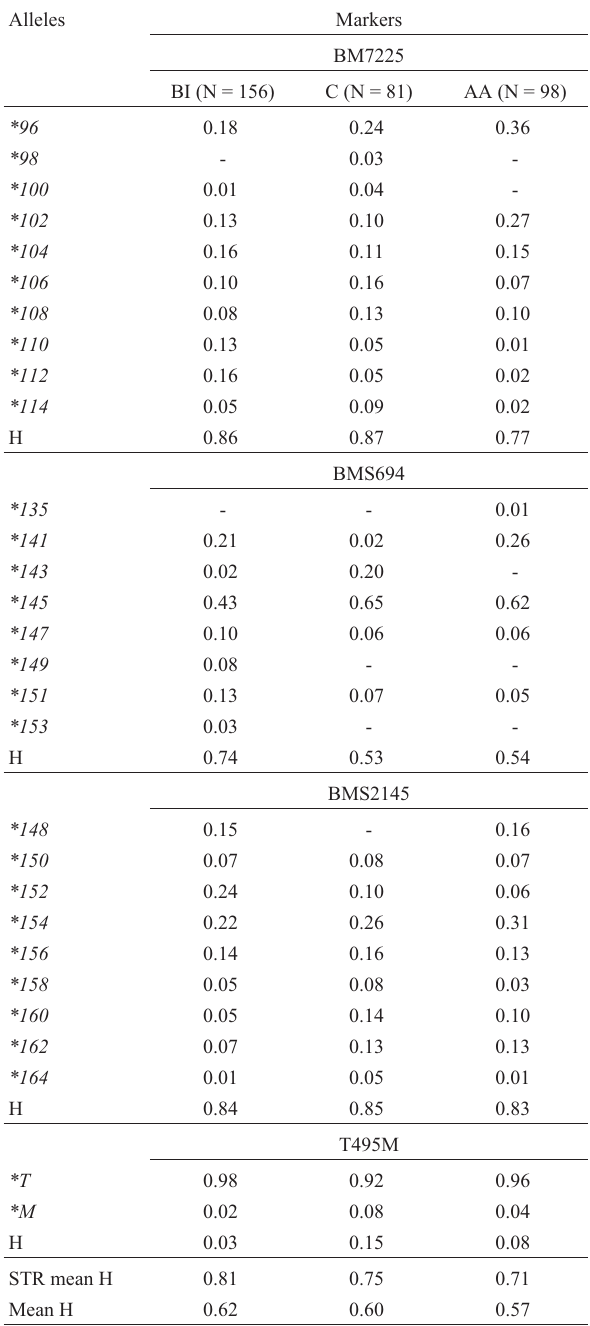
Table 2 - Allele frequencies and heterozygosities (H) in Brangus Ibage (BG), Charolais (C), and Aberdeen Angus (AA) breeds.